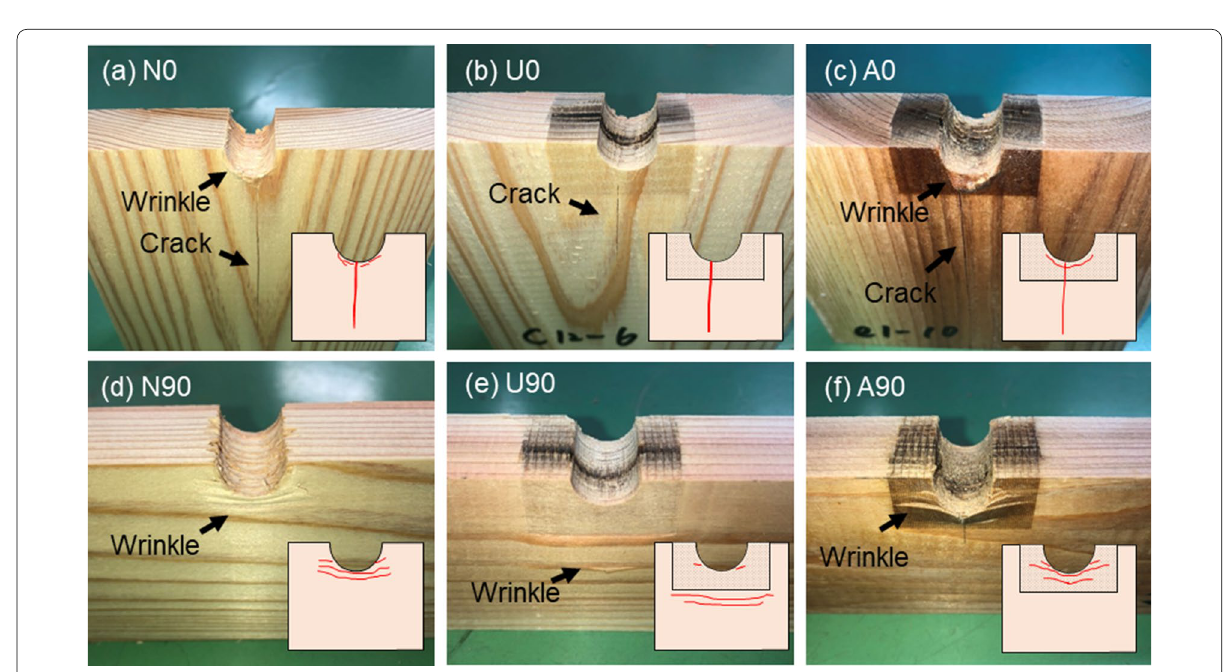
Fig. 6 Failure modes visually